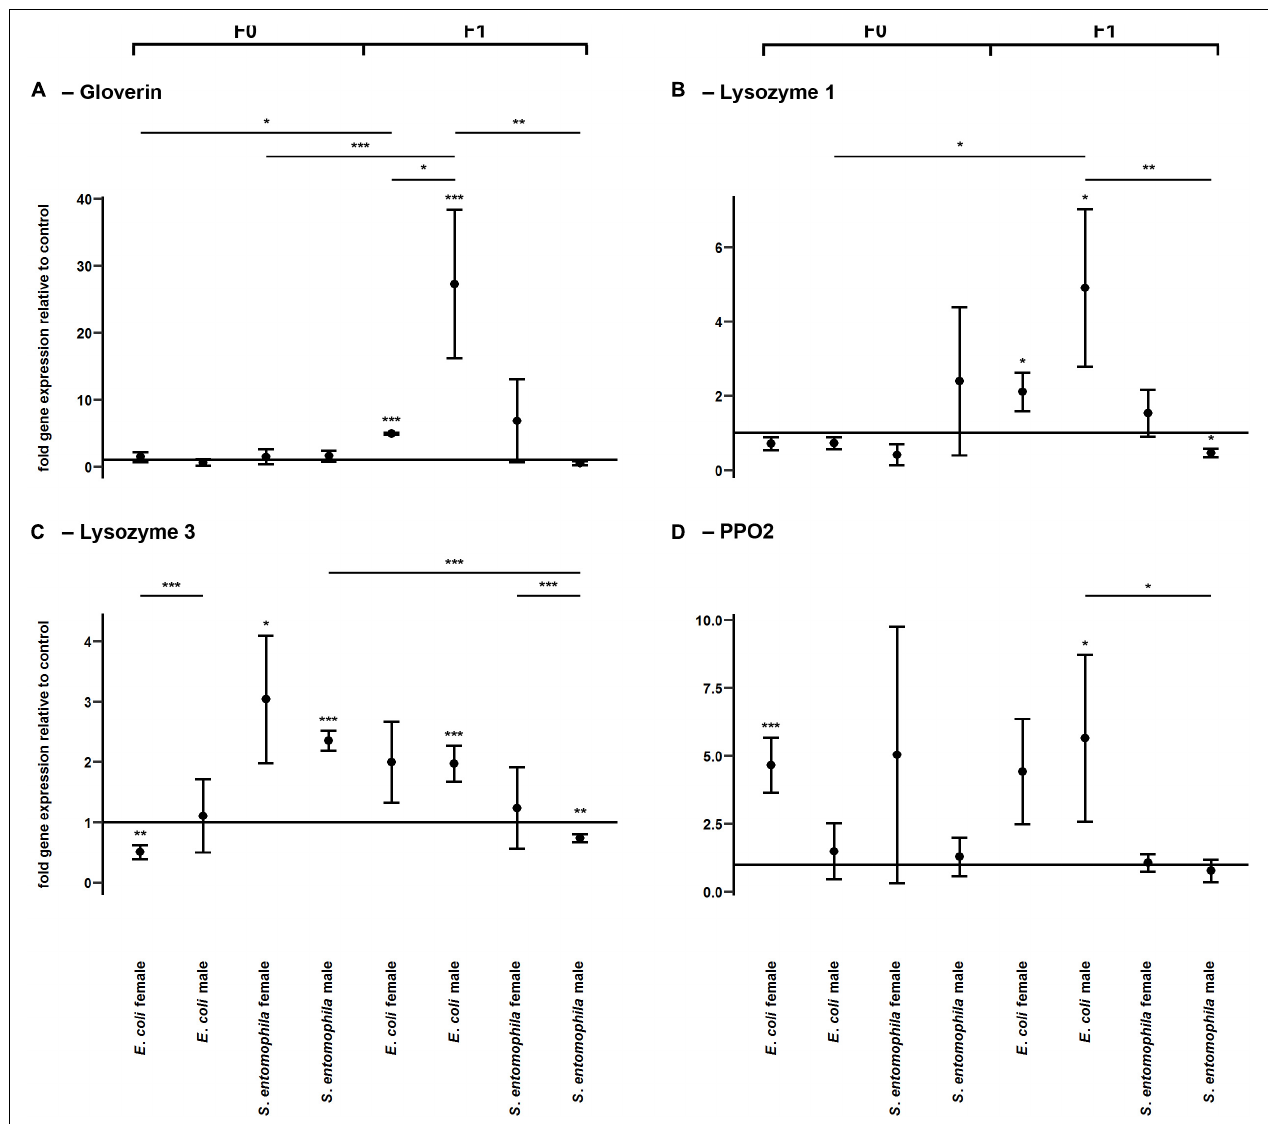
FIGURE 4 | Differential expression of immunity-related genes. Relative expression levels of immunity-related genes in the parental generation reared on bacterial diets (pathogenic and non-pathogenic) or uncontaminated control diets (F0) and unchallenged offspring (F1). The target genes were: (A) gloverin, (B) lysozyme 1, (C) lysozyme 3, and (D) pro-phenoloxidase 2. Relative fold changes for each gene were set to 1 for the control treatment and normalized against the 60S RNA housekeeping gene. Results represent the mean values of three independent biological replicates and error bars indicate the standard error of the